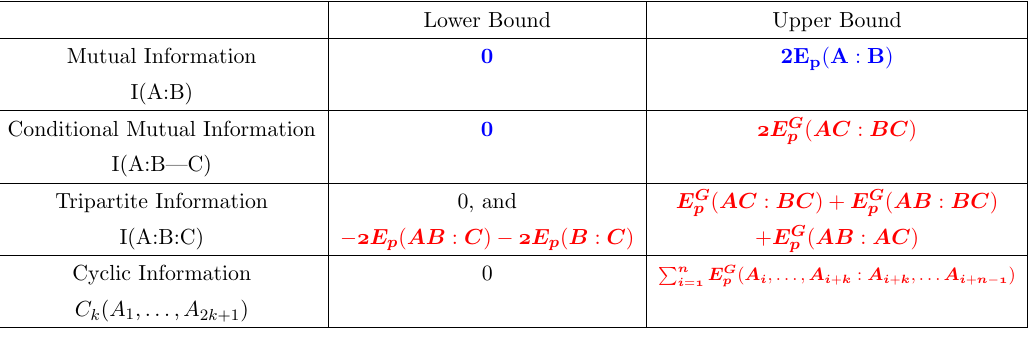
Table 1 . The main results are listed in the table. In standard black font are the results that only hold for holographic states. All others hold for general quantum states. Results that, to the best of the authors knowledge, are new are in red bold italics text (the upper bound on conditional mutual information was proved for E W in the language of bit threads in [14]). In blue bold text are the inequalities that were already known to hold for all quantum states. In addition to these results, we have also shown the holographic inequality in eq. (3.20), which does not (cid:12)t neatly into this table. The general version of this inequality, pending the E W = E p conjecture, is given by eq. (4.12). We have shown this to hold for several non-holographic states, but its general validity is still an open